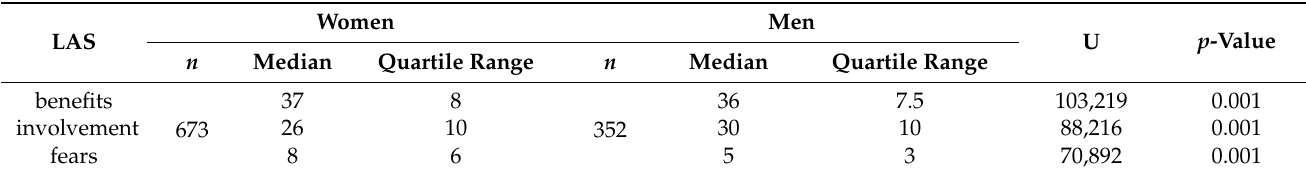
Table 2. Attitude to forest—comparing females and